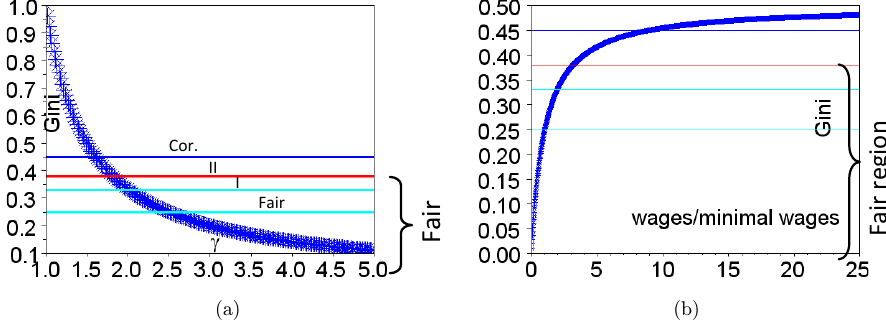
Fig. 2. (a) The Gini for the Pareto income density function as a function of the power (cid:5) , where the fair Gini is within the light blue horizontal lines. The three other regimes are highlighted, I (departure from fairness), II (corruption built nation), Cor. (corrupt). (b) The society income curve on a log linear scale, with normalization, wages/minimal wages ( y -axis). This function is the income of every percentile in the society. Red curve is the exponential income curve (lower curve, stars), the blue curve is the Pareto income curve with (cid:5) ¼ 2 (circles) and the black curve is the Pareto income curve with (cid:5) ¼ 1 (upper stars); it is clear that those in the top 0.1% are very rich just in the Pareto (cid:5) ¼ 1 curve, where in the other cases, each curve is continuous and the rich are just moderately